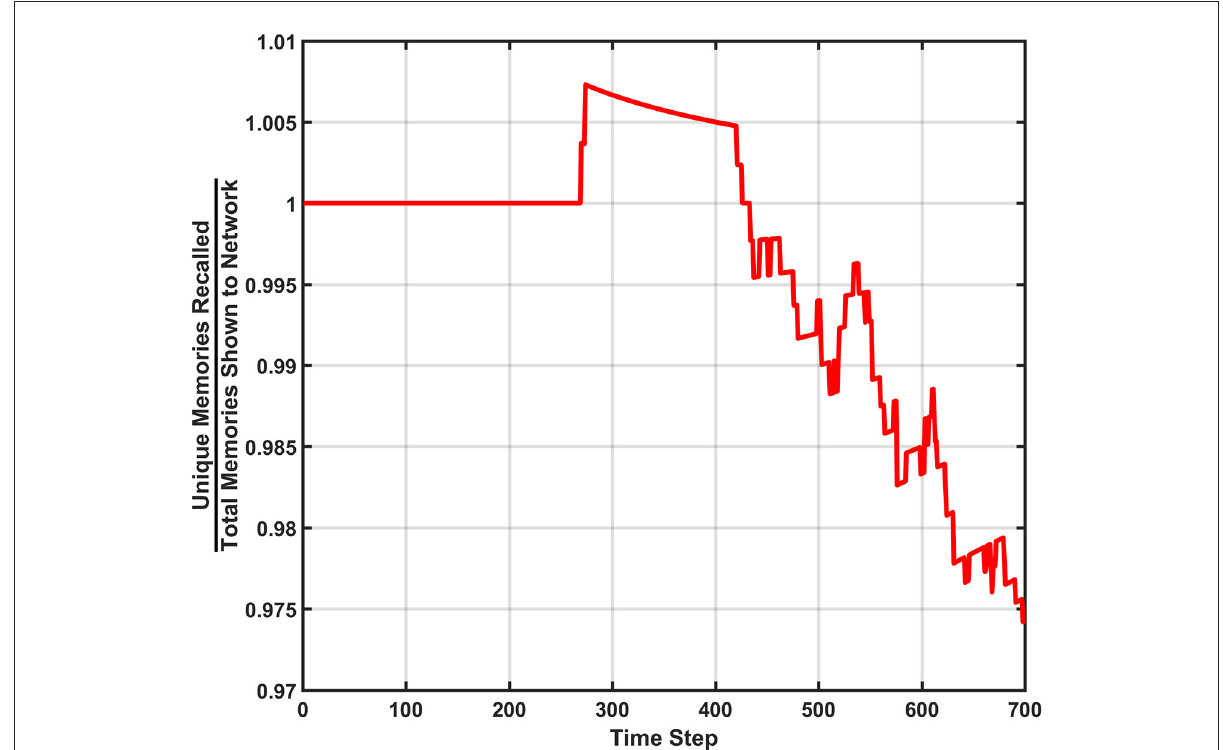
FIGURE4 Unique memory ratio for the basic SAN run against the EHoS dataset. At each time step, the ratio tallies the amount of unique memories recalled in that time step’s evaluation and divides it by the total number of memories shown to the network so